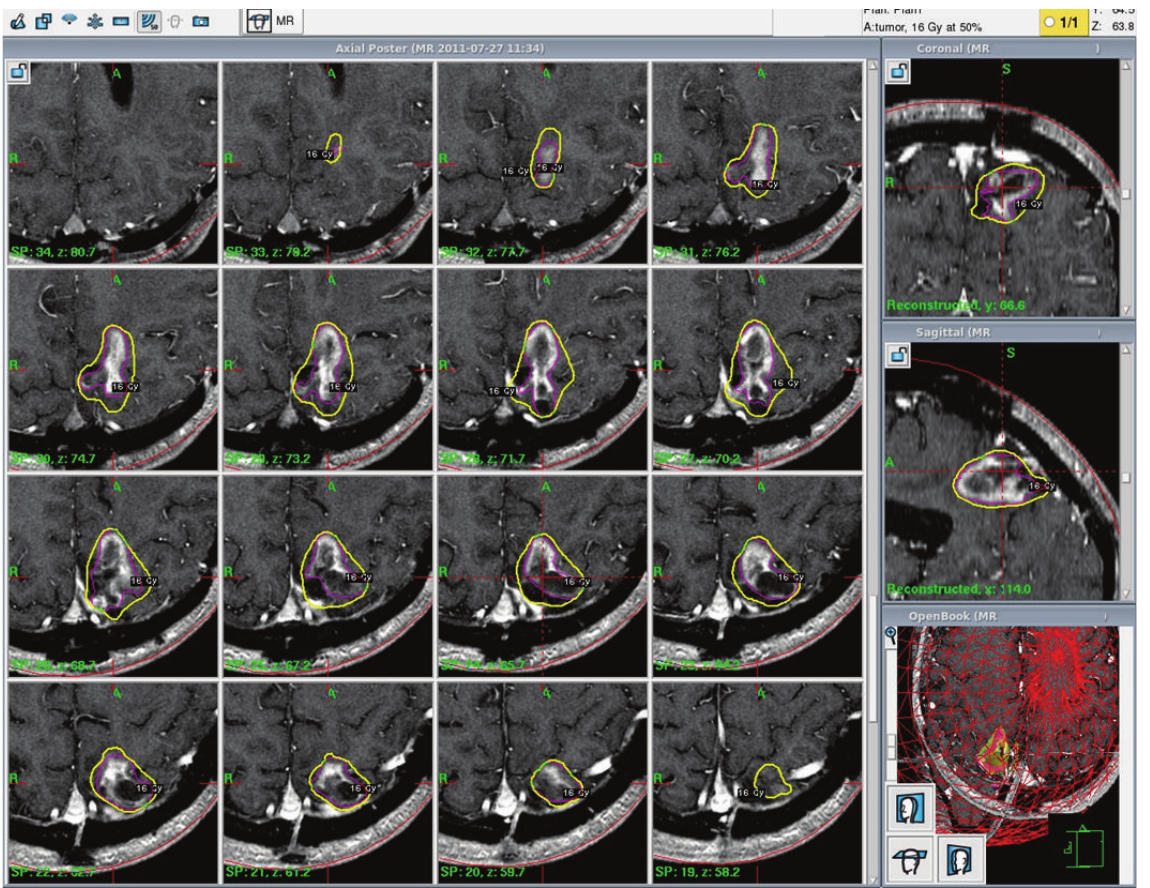
Figure 4: Treatment planning for second salvage GKRS treatment after the second recurrence of GBM. Again, 16Gy was prescribed to the 50% isodose